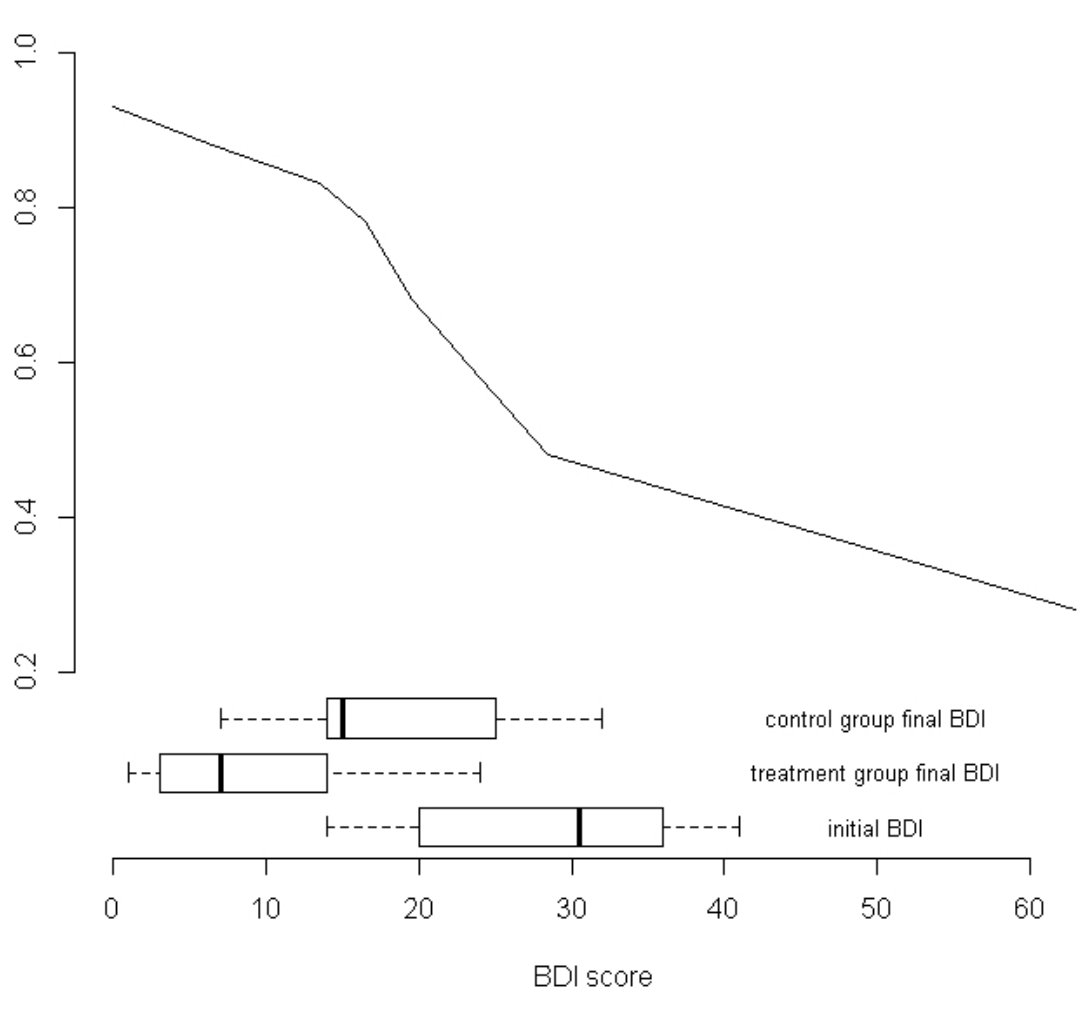
Figure 1. Box-plots of BDI scores for patients, entering the pilot trial (initial BDI) and treatment/control groups at the end of the pilot trial (piecewise linear line shows how BDI score [horizontal axis] is mapped onto the QALY scale [vertical